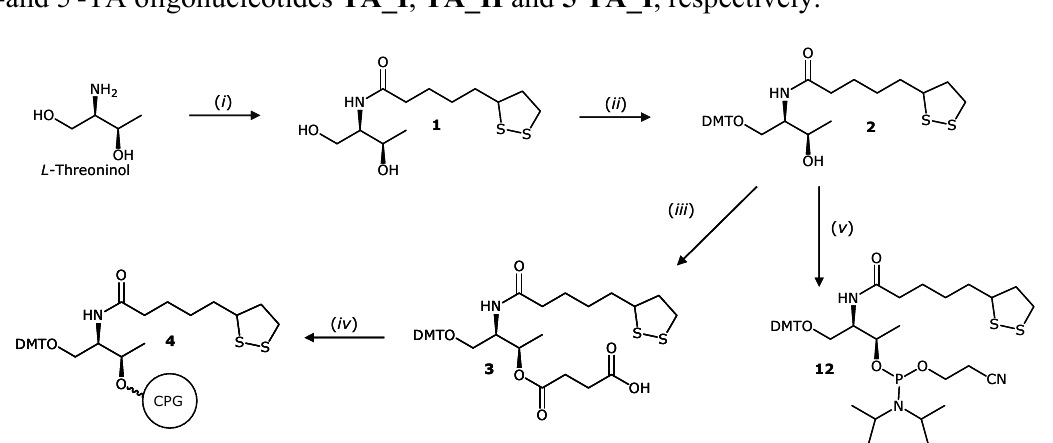
Scheme 1. Synthesis of solid support 4 and phosphoramidite 12 used for the preparation of 3'-and 5'-TA oligonucleotides TA_I , TA_II and 5'TA_I ,